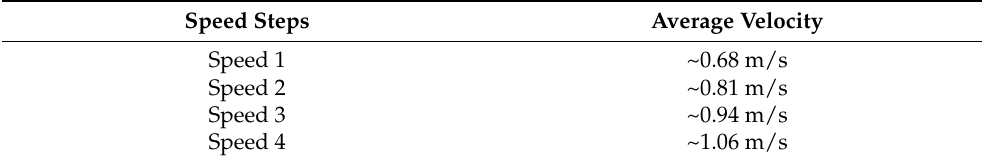
Figure 3. Sketch of the experimental setup, showing the track and the placement of the VLS unit. The speed and the direction of the train were controlled via a wireless Bluetooth based controller unit. The direction of the train was kept constant throughout the experi- ments. The speed could be controlled in distinct steps. The chosen speed steps in the ex- periments are further on referred to as Speed 1, Speed 2, Speed 3 and Speed 4. The corre- sponding average velocities of the train are given in Table 3. Table 3. Speed steps applied in the experiments and the corresponding average velocities of the train.